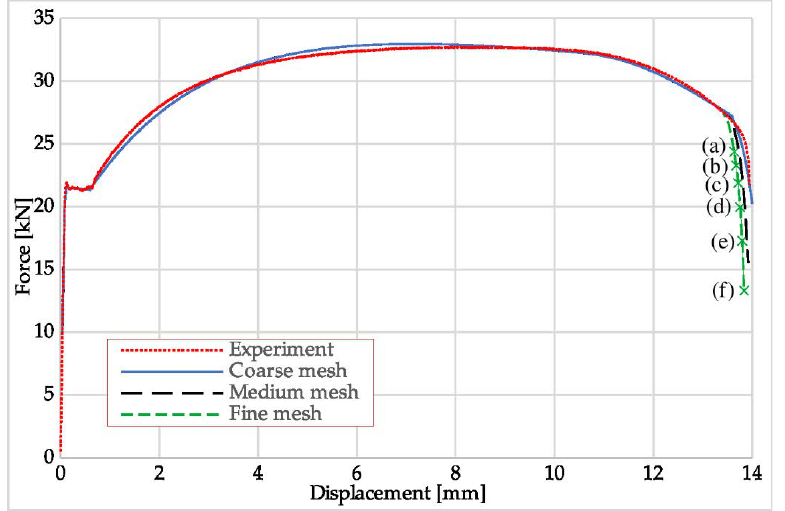
Figure 15. Effect of the mesh size on the force–displacement response: the specimen’s top surface displacement for the fine mesh ( a ) 13.64 mm, ( b ) 13.68 mm, ( c ) 13.72 mm, ( d ) 13.76 mm, ( e ) 13.80 mm, ( f ) 13.84